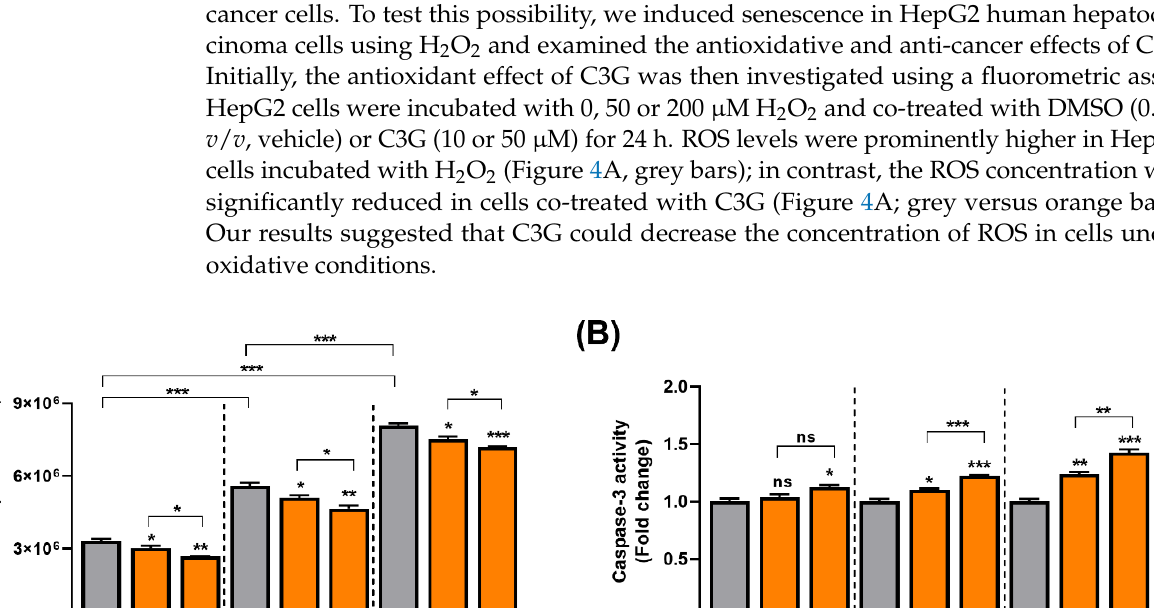
Figure 5. Effect of C3G on anti-cancer activity by inducing senescence in hepatocarcinoma cells. ( A ) SA-β-Gal activity in HepG2 cells treated with 50, 100 and 200 µM H 2 O 2 . Micrographs were obtained with phase contrast microscopy. ( B ) Quantification of SA-β-Gal+ cells cultures shown in A. SA-β- Gal+ cells were scored in 3 fields of at least 450 total cells. The results represent the mean ± SEM (n = 3). For comparisons between two groups, Student’s t -test was performed. *, p < 0.05; **, p < 0.01;